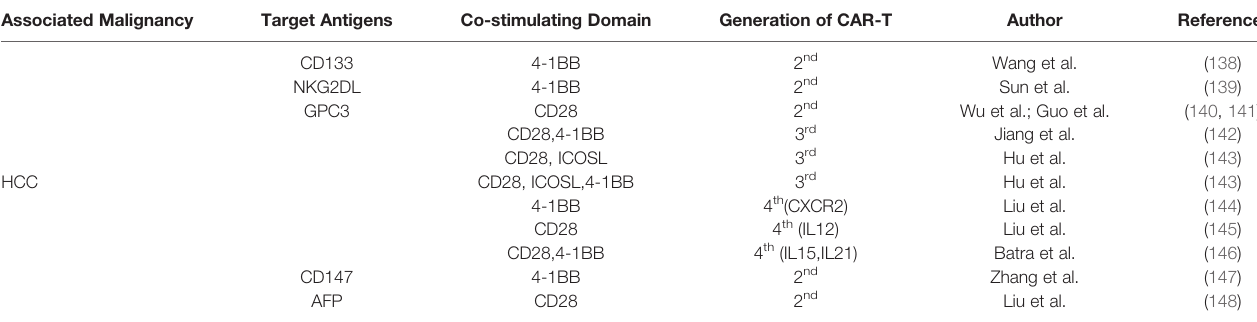
TABLE 3 | Some liver cancer-related CAR-T cell therapy